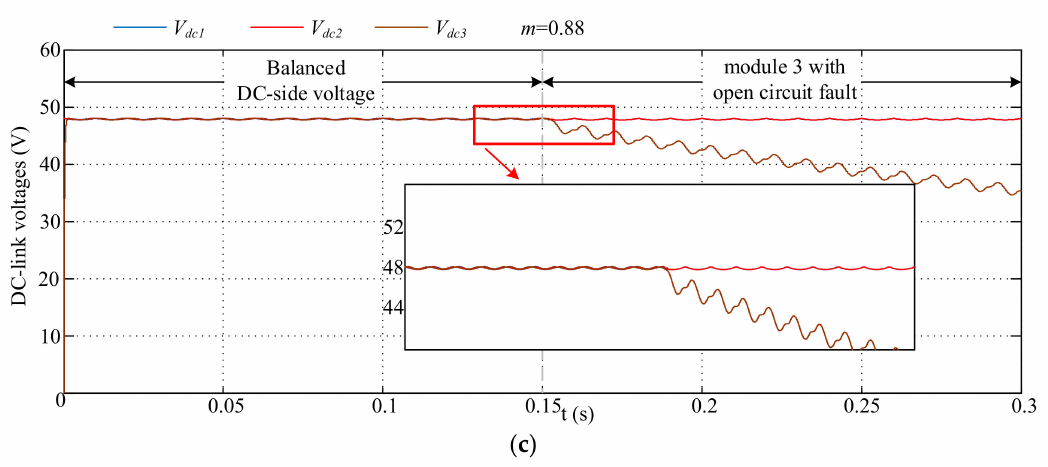
Figure 9. DC-side voltages of each module. ( a ) Each DC-side voltage of the proposed strategy ( m = 0.78); ( b ) each DC-side voltage of the proposed strategy ( m = 0.82); ( c ) each DC-side voltage of the proposed strategy ( m =